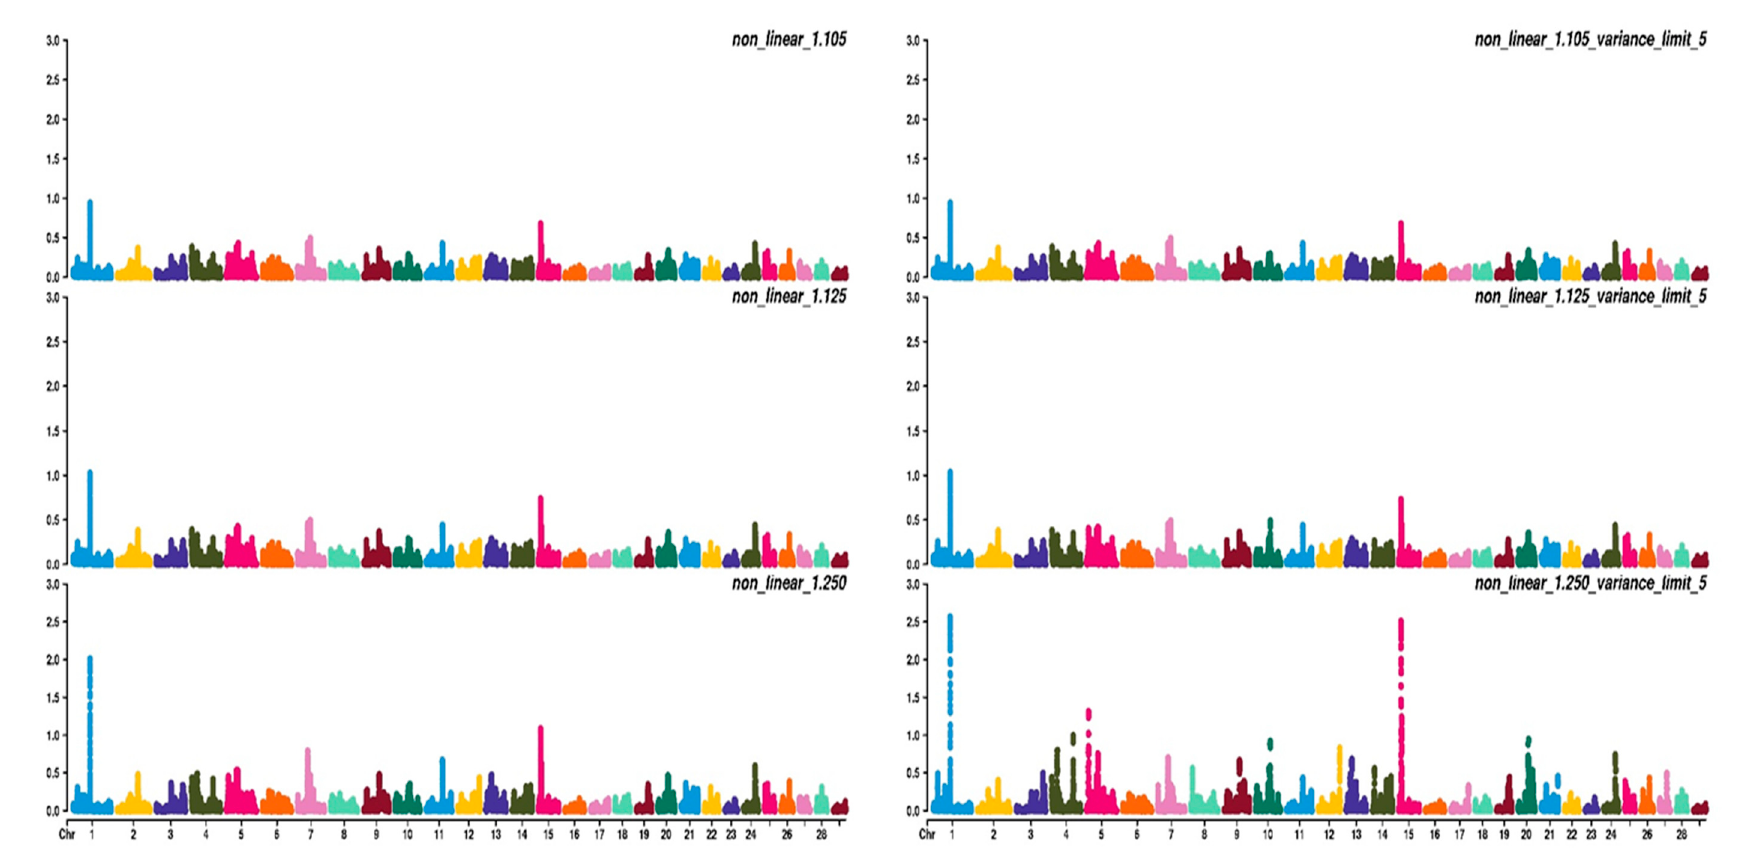
Figure 3. Manhattan plots for average daily gain (ADG) using different WssGBLUP strategies in iterations equal to 10; y-axes represent the percentage explained by each SNP. Variance explained was calculated with a sliding window approach.